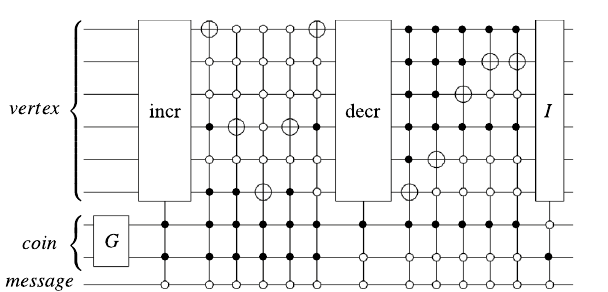
0 alone a 37-length cycle =